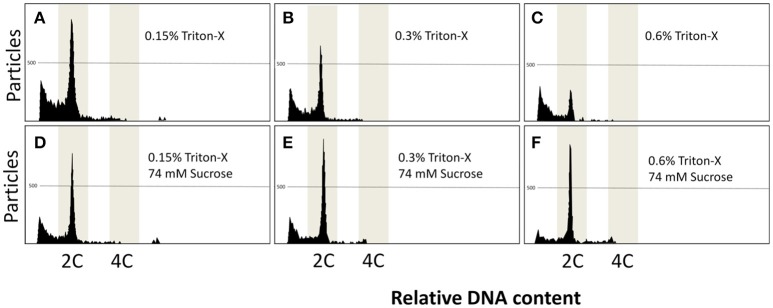
(A–F) Flow cytometric charts of fin samples using various lysing treatments and staining with DAPI. A combination of Triton-X 0.15, 0.3, and 0.6% was associated with sucrose at 74 mM. Triton-X produced noisy peaks at all concentrations. The addition of sucrose improved the results, giving rise to clear peaks.